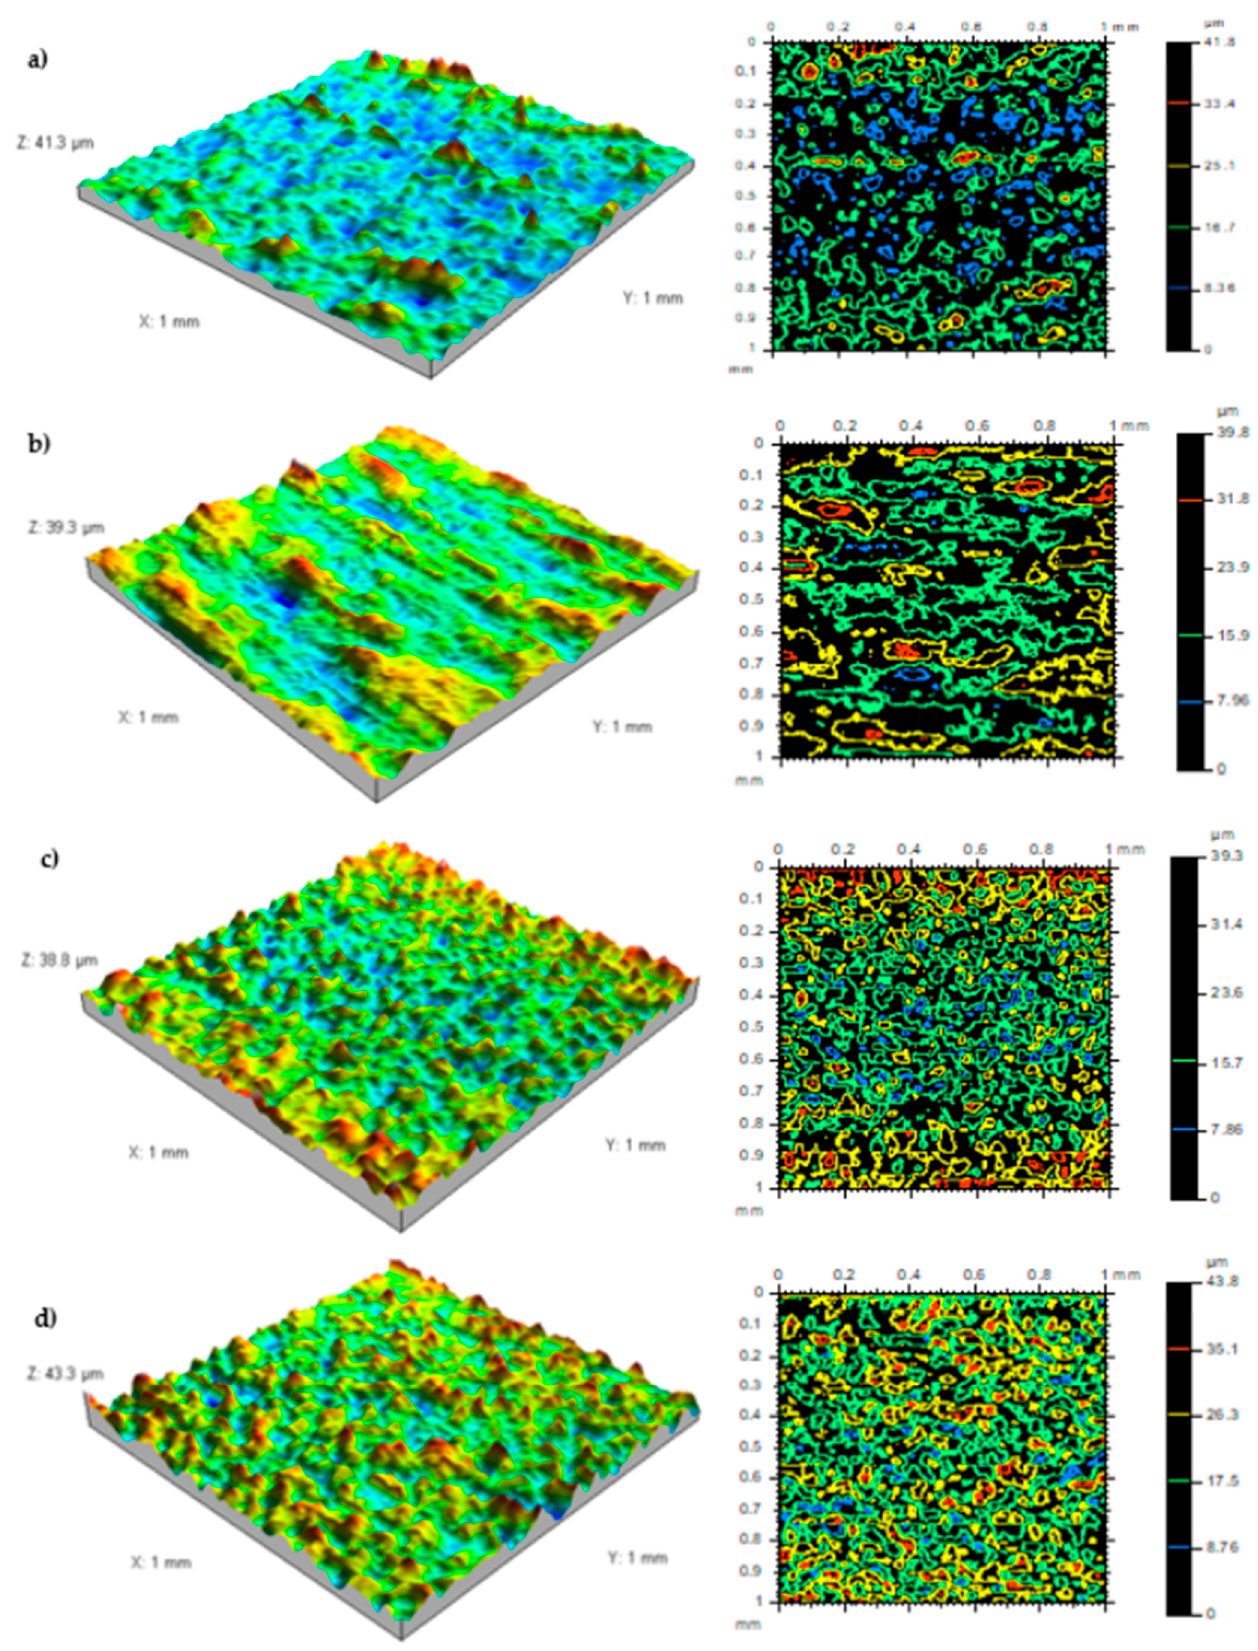
Figure 3. The surface of ( a ) the reference material and the material covered with biofilm after ( b ) 15 days, ( c ) 30 days, and ( d ) 45